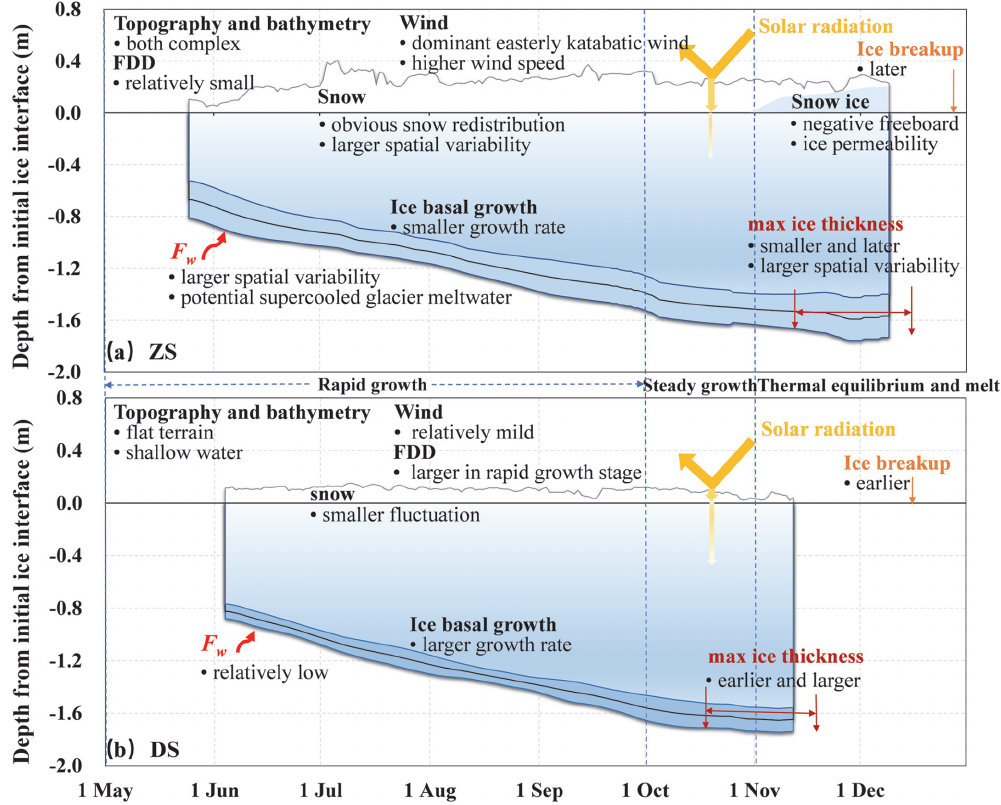
Figure 10. Schematic diagram of the seasonal and interannual characteristics of LFI near ZS (a) and DS (b) , with the critical factors that are responsible for the LFI variations. The gray, black, and blue lines represent the spatially averaged snow depth, LFI thickness, and the LFI thickness ± standard deviation,